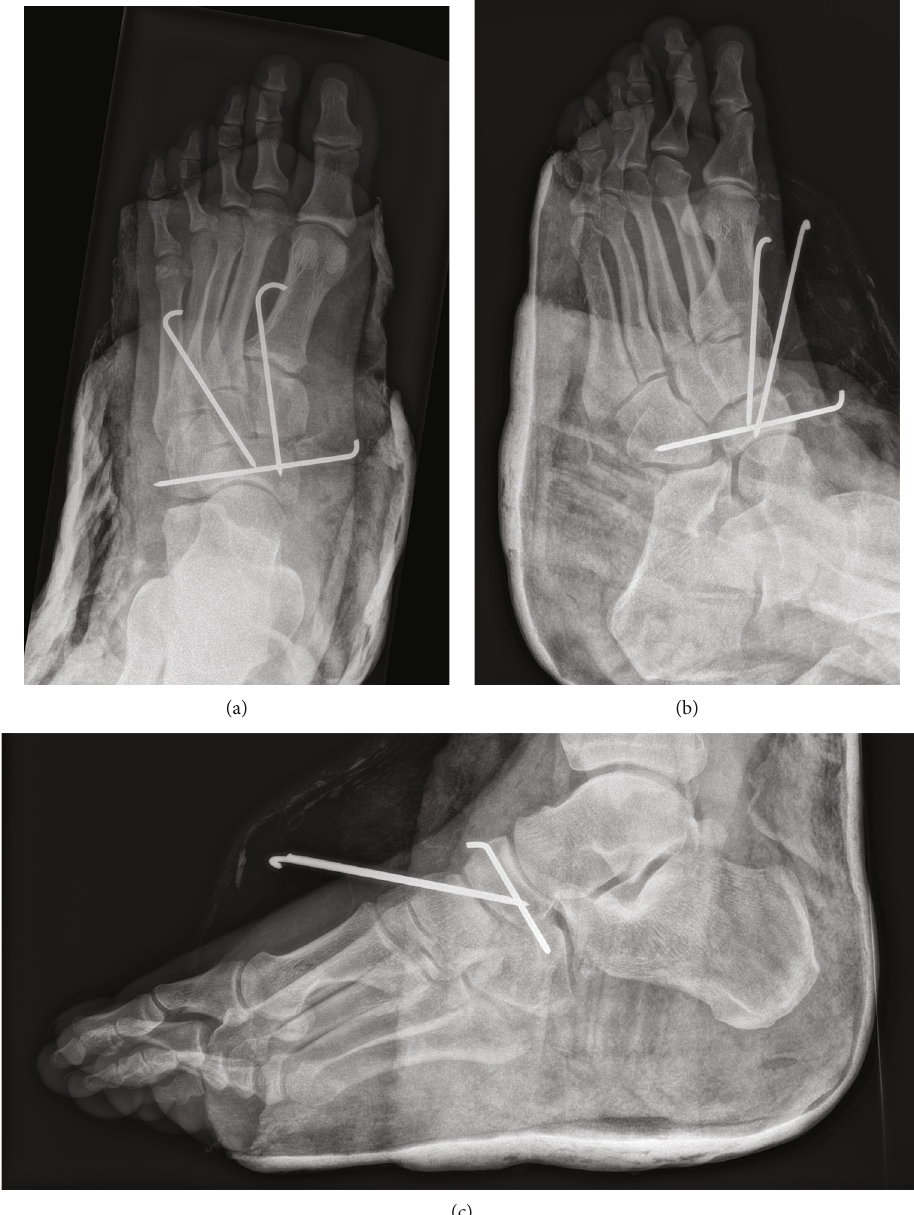
Figure 3: (a) Anteroposterior, (b) oblique, and (c) lateral X-rays of the left foot after closed reduction and percutaneous